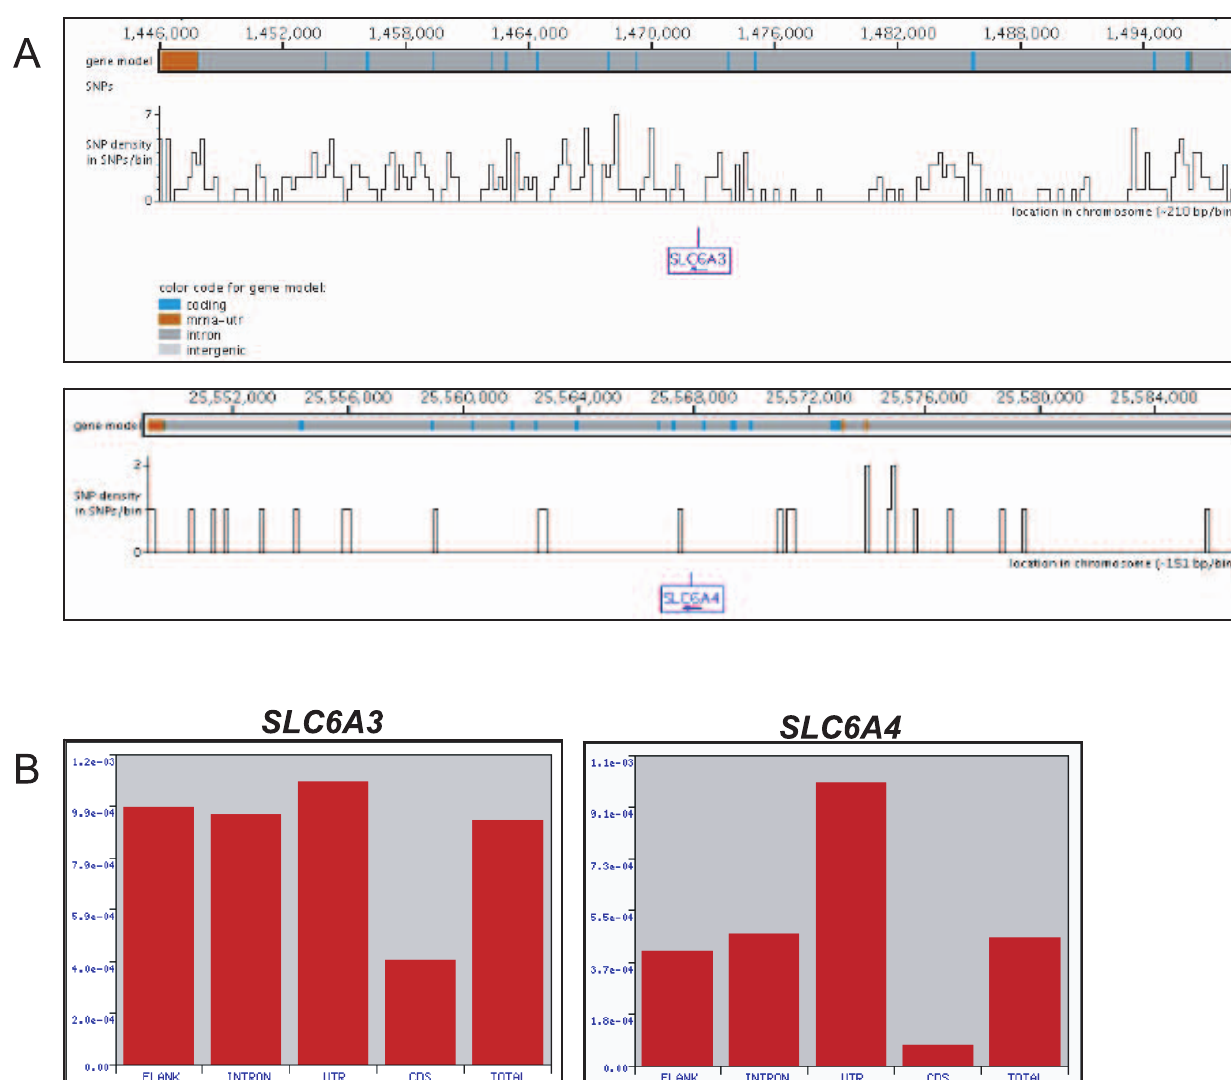
Figure 5. SNPs frequency and distribution within the chromosomal regions of the SLC6A3 and the SLC6A4genes . A – Chromosomal maps were produced by the Genome Variation Server in a ‘‘summary SNPs display’’ view (the SLC6A3 map - top panel, and the SLC6A4 map – the lower panel). Single peaks are indicating genomic positions of SNPs where peaks height corresponds to the SNP frequency (filtering – default options, merge option - common samples with combined variations ). B - Regional frequency of the SNPs in the SLC6A3 (left) and the SLC6A4 (right).